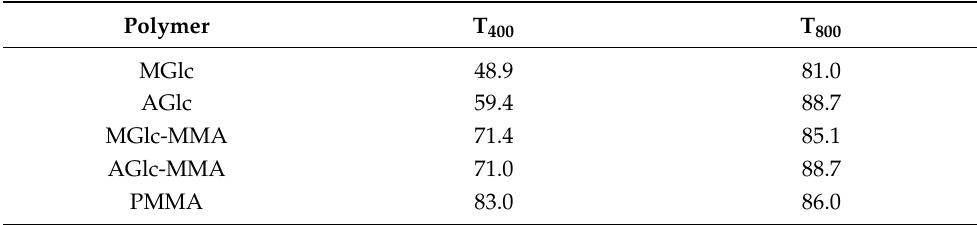
Table 3. Optical properties of homopolymers of MGlc and AGlc, and copolymers with MMA. Transmittance at 400 and 800 nm, respectively.